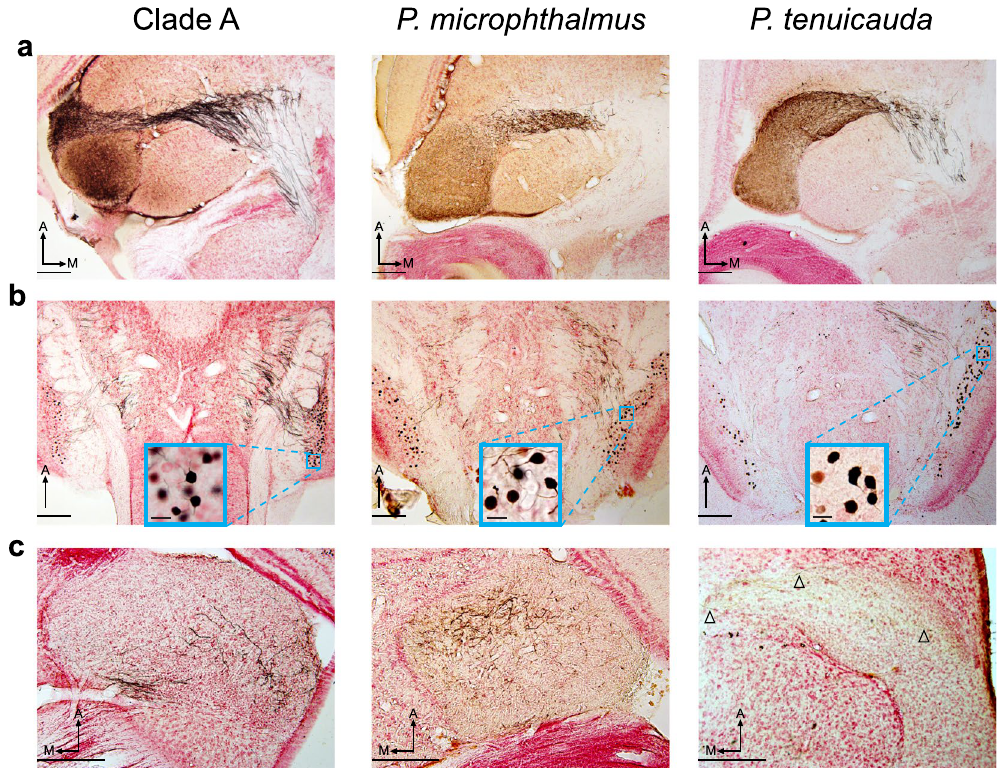
Figure 2. Neurons from the hindbrain nELL project bilaterally to the midbrain in all three lineages. Iontophoretic injections of neuronal tract tracers in the left ELa of a clade-A species ( B . niger , left) and P . microphthalmus (center), and in the anterior end of the left EL in P . tenuicuda (right) labeled axonal projections through the lateral lemniscus ( a ) and backfilled somas in the left and right hindbrain nELL ( b ). The majority of backfilled neurons were in the right nELL in the three lineages (Clade A: B . brachyistius n = 61stained cells total, 60% contralateral; B . niger subject 1: n = 494, 67% contralateral; B . niger subject 2: n = 559, 69% contralateral; B . niger subject 3: n = 308, 64% contralateral; G . petersii : n = 204, 67% contralateral. P . microphthalmus subject 1: n = 156 stained cells total, 59% contralateral; P . microphthalmus subject 2: n = 481, 68% contralateral. P . tenuicauda subject 1: n = 10 stained cells total, 70% contralateral; P . tenuicauda subject 2: n = 523, 71% contralateral; P . tenuicauda subject 3: n = 21, 75% contralateral). ( c ) Stained axonal projections in the right ELa and anterior end of the right EL show that some projections from the hindbrain are bilateral. Insets in ( b ) show close-ups of stained somas of nELL neurons contralateral to the injection site. All photomicrographs are from 50- µ m horizontal sections of the brain. Scale bars in the insets in ( b ) represent 20 µ m; all other scale bars represent 200 µ m. Arrowheads point to labeled axonal projections in the contralateral EL of P . tenuicauda . All photomicrographs were taken from the same subject in each lineage. The injection sites are not visible in these sections. With respect to the photomicrographs in ( a ), injection sites were: 250 µ m dorsal and towards the lateral edge of ELa in clade A; 400 µ m dorsal and towards the anterior edge of ELa in P . microphthalmus ; 250 µ m dorsal and towards the anterolateral edge of EL in P . tenuicauda . A: anterior. M: